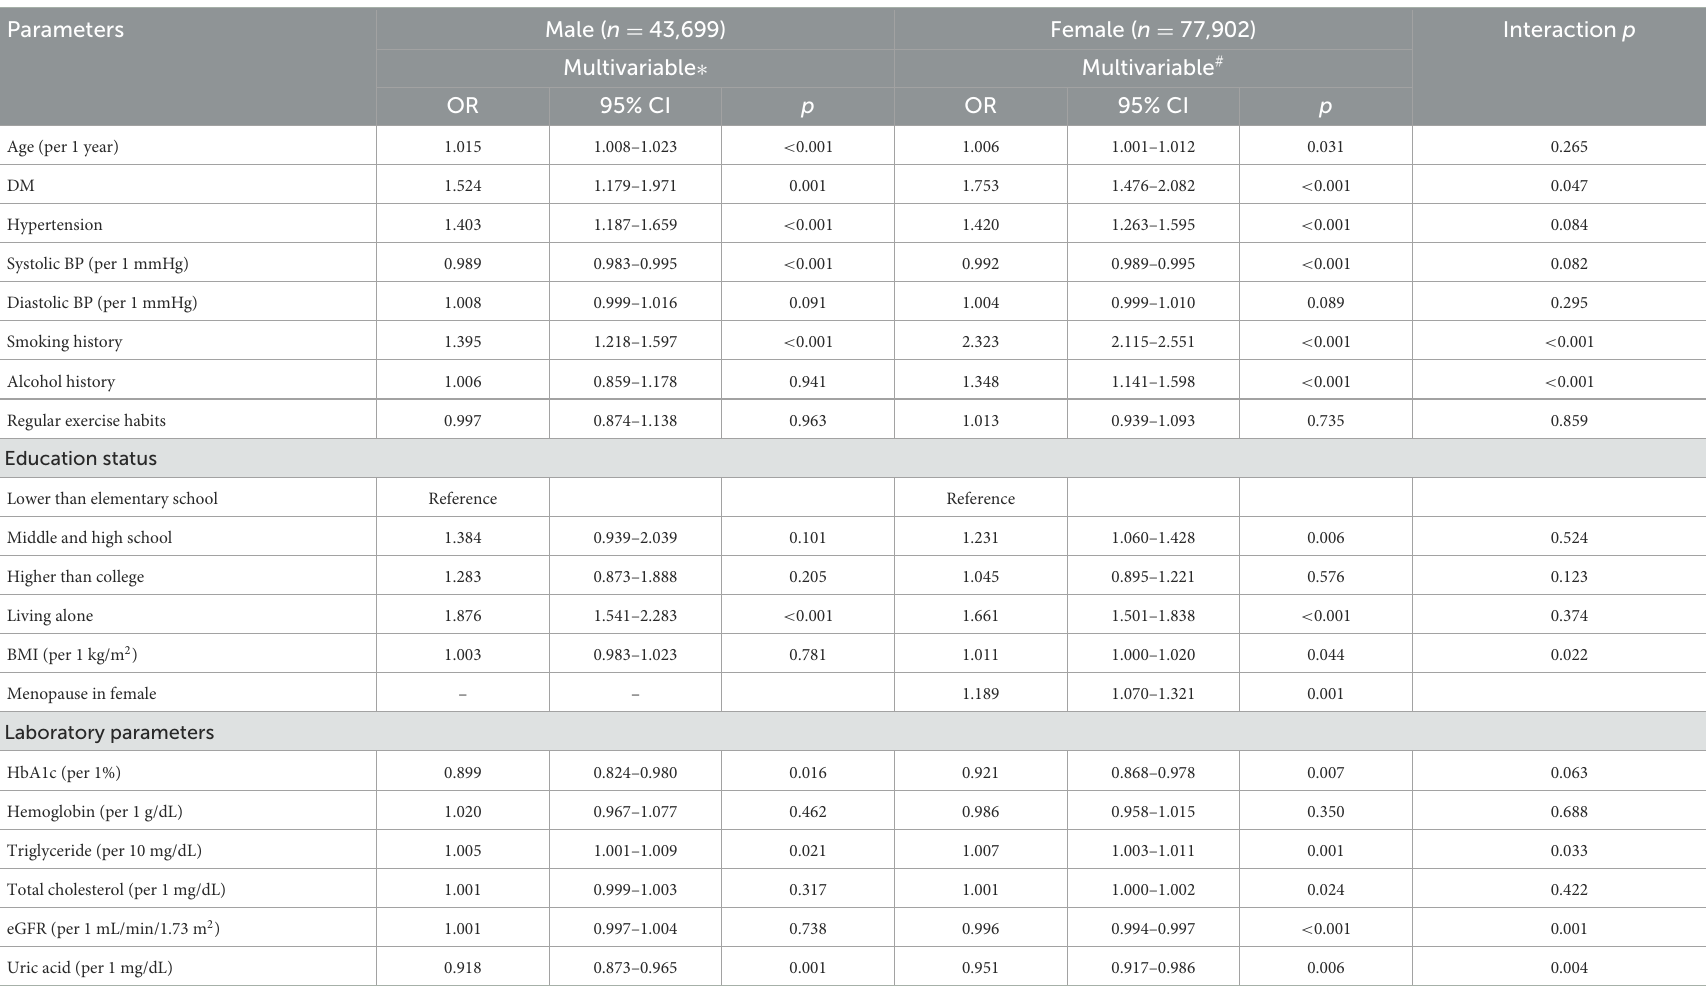
TABLE 3 Association of risk factors with depression using multivariable logistic regression analysis in different